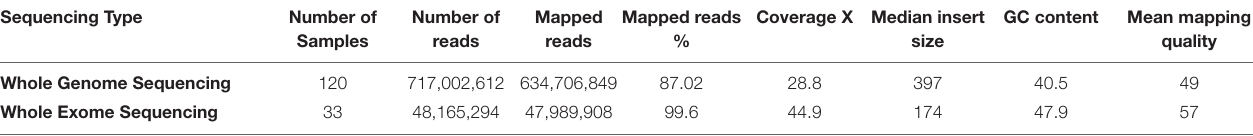
TABLE 1 | The average alignment and genome coverage for the 153 WGS/WES from mapping the raw reads of each sample to the hg19 reference genome. Sequencing Type